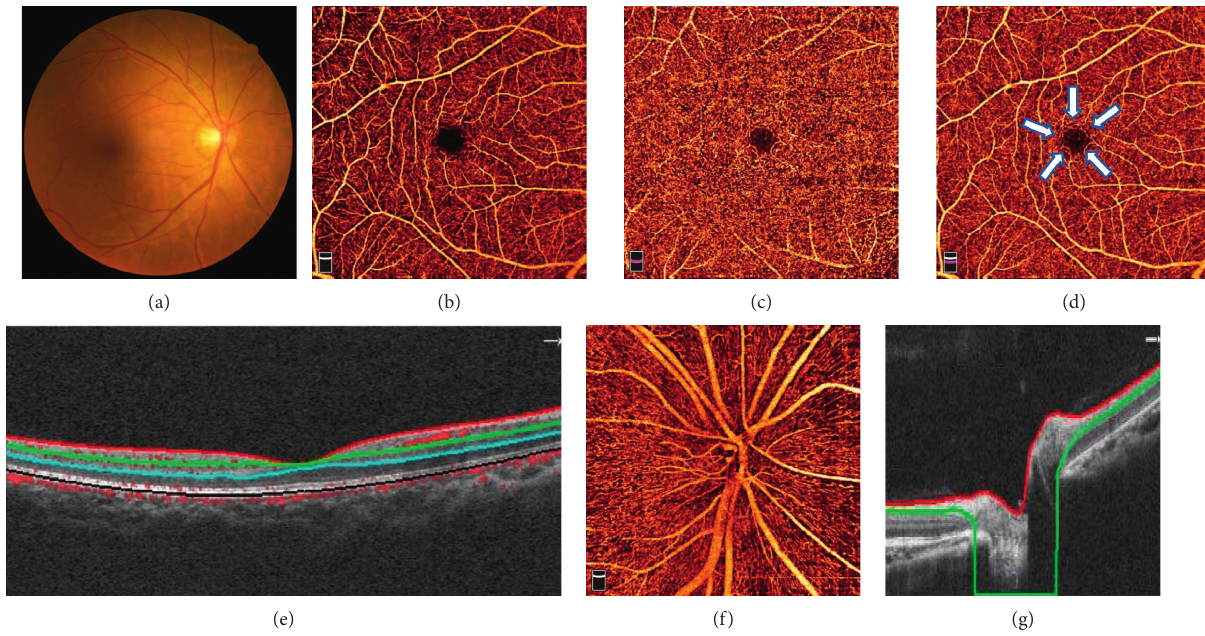
Figure 1: Optical coherence tomography angiography (OCTA) assessments. (a) Color fundus photographs, (b) macular 6 × 6mm OCTA image in the superficial vascular plexus (inner plexiform layer (ILM) - inner plexiform layer (IPL): area between the red and green lines in (E)), (c) macular 6 × 6mm OCTA image in the deep vascular plexus (IPL - outer plexiform layer (OPL): area between the green and blue lines in (e)), (d) foveal avascular zone: white arrowhead, (e) a horizontal OCT B-scan of the retina, (f) optic nerve head (ONH) 4.5 × 4.5mm OCTA image: area between the red and green lines in (g), and (g) a horizontal OCT B-scan of the